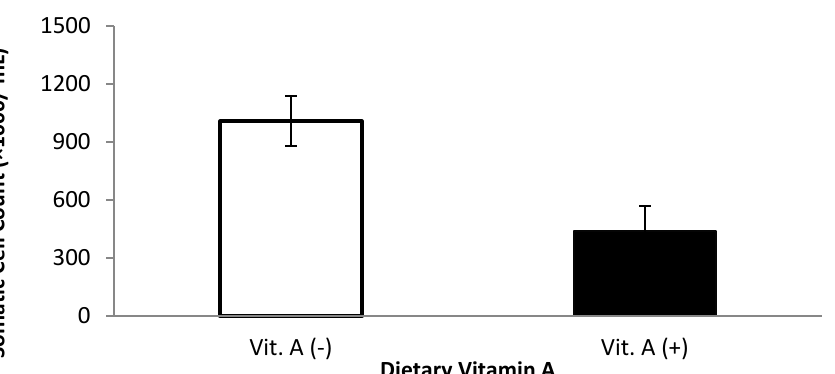
Figure 1. Somatic cell count for multiparous Holstein dairy cows ( n = 80, total) that were fed diets with crude protein levels (10.3%, n = 40 vs. 12.2% dry matter basis, n = 40), and within each crude protein group that was fed monensin (400 mg/day per head or none) and vitamin A (110 IU/kg body weight or none) during prepartum period (from day − 35 to the day of calving). All cows received a common lactation ration postpartum. Dietary vitamin A interaction ( p =